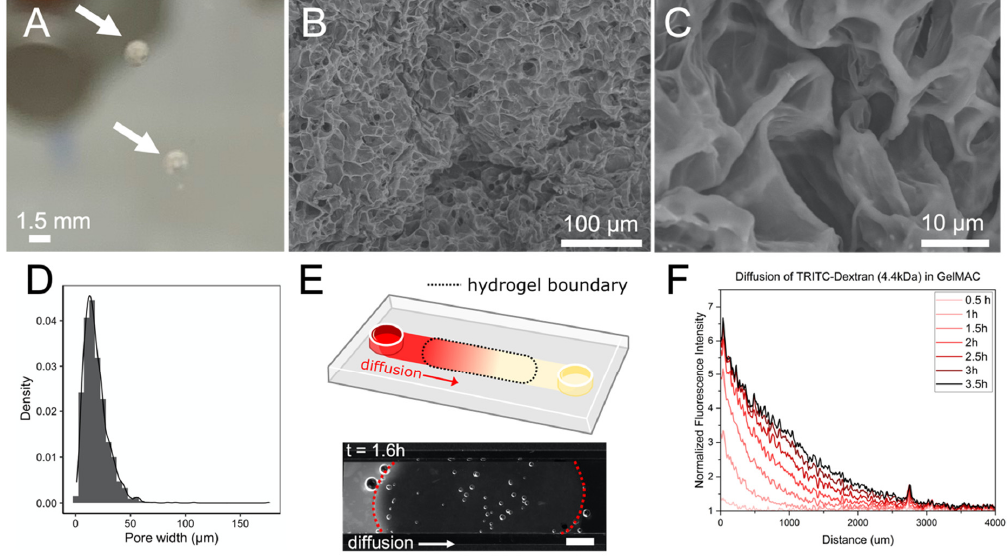
Figure 1. SSAs mimic the properties of natural soil aggregates. ( A ) A macroscopic perspective of the translucent SSAs (indicated by white arrows). ( B, C ) Scanning electron microscope images illustrate the heterogenous pore network within an individual SSA. ( D ) The pore size distribution within an SSA has a mean value of 18.5 µm and a standard deviation of 11.6 µm. ( E ) GelMA C was loaded into a fluidic channel (top) and the diffusion of 4.4 kDA TRITC-dextran through the hydrogel was tracked using fluorescence microscopy (bottom, hydrogel boundaries outlined in red, scale bar shows 2 mm). ( F ) The diffusion of 4.4 kDA TRITC-dextran through the GelMA C over time was used to calculate the diffusion coefficient of the compound through the